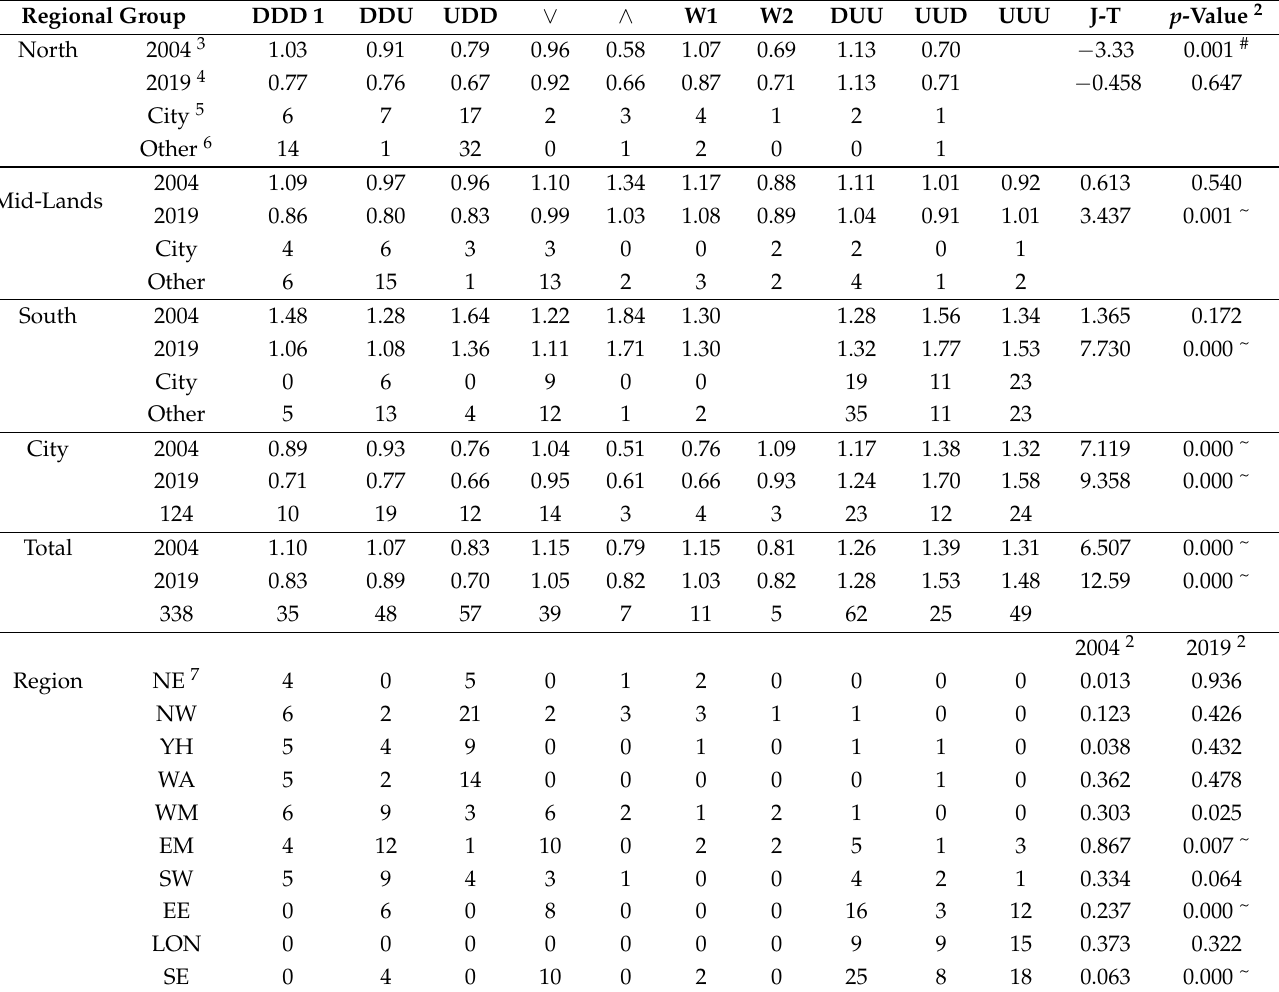
1 Profiles. See Figure 3; 2 p -values of the Jonckheere-Terpstra (J-T) Test; 3 District harmonic mean for 2004 ÷ 5.85; 4 District harmonic mean for 2019 ÷ 7.85; 5 Number of City districts with the corresponding profile; 6 Number of Other districts with the corresponding profile; 7 Number of NE districts with the corresponding profile—see Table 1; # Sig at 1% level negative order; ~ Sig at 1% level positive